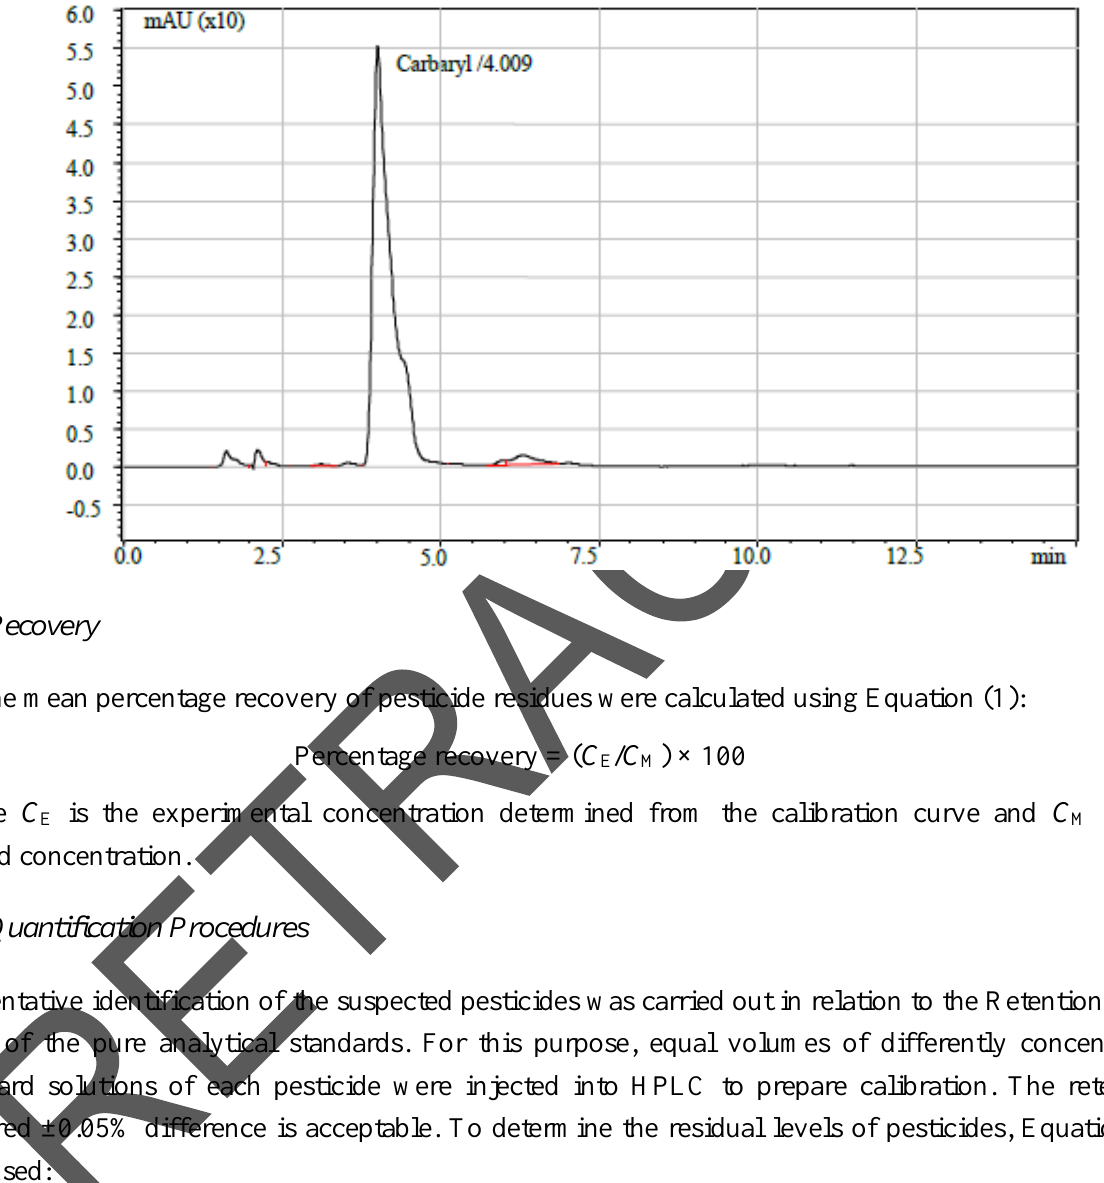
Figure 2. Typical chromatogram of carbaryl standard injected at 50 mg/kg (retention time 4.009